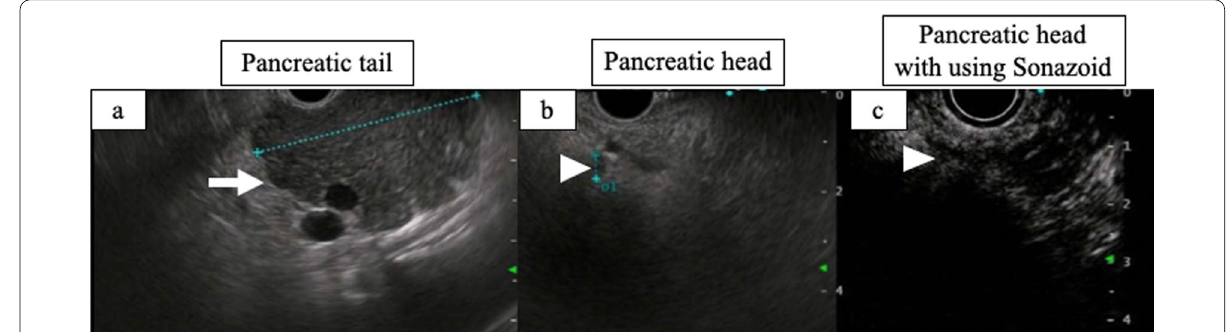
Fig. 5 Endoscopic ultrasonography. a A hypoechoic lesion, 55 mm in diameter, is detected in the pancreatic tail (white arrow). b A hypoechoic lesion, 5 mm in diameter, is detected in the pancreatic head (white arrowhead). c A hypoechoic lesion is not enhanced with Sonazoid (white